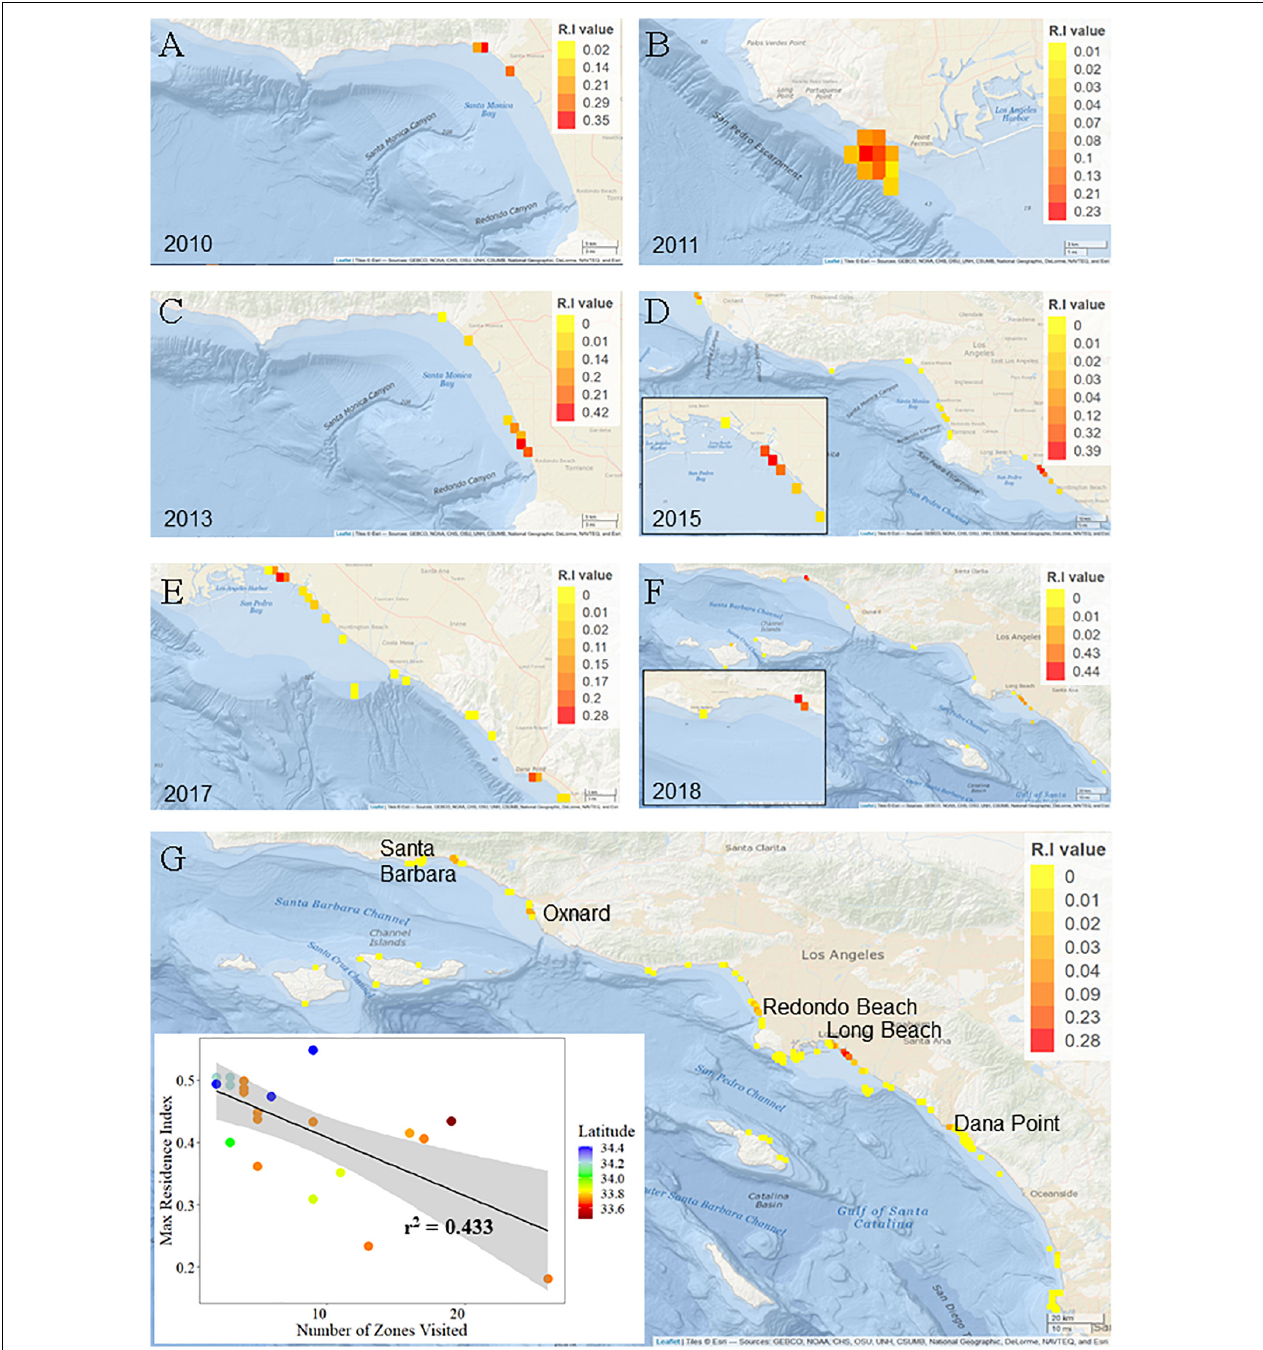
FIGURE 5 | Residency indices for young of the year white sharks in southern California. Grid cells are approximately 1.2 km 2 . Note the scale bar for residency values changes across years. (A–F) Indicate location of zones of highest YOY white shark residency for each year of the study, colored by RI value. (G) Base-map showing cumulative residency values for all zones across all years. Inset scatter plot shows approximate latitude of the zone of highest residency for each YOY white shark included in residency analyses.